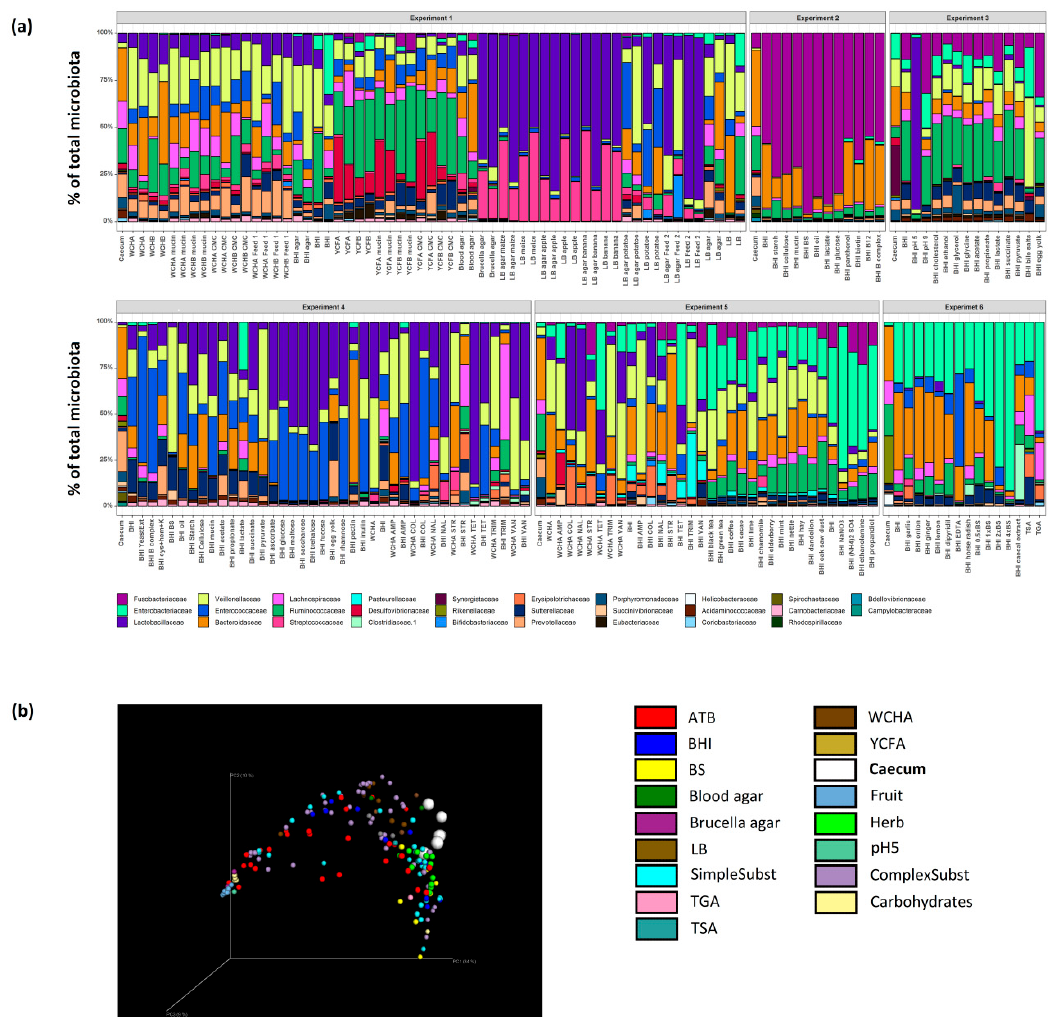
Figure 3. Identification of the most selective growth conditions. ( a ) The six independent experiments di ff ered considerably due to di ff erent inoculum and tested growth conditions. ( b ) PCoA analysis of all analysed samples showed that those which di ff ered the most from the original caecal samples originated from media supplemented with bile salts, mono- and di-saccharides, fruits and antibiotics (ATB). See Figure S2 to zoom